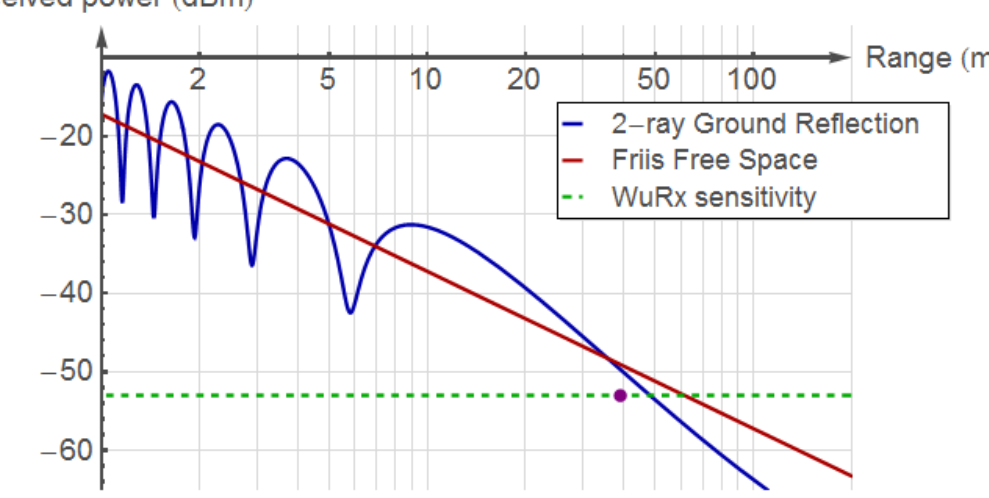
Figure 10. Simulation of theoretical received power of SCM-WuRx at different distances vs . its measured